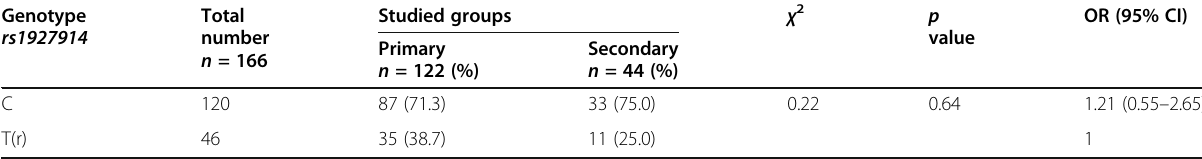
Table 5 Association between TLR genetic polymorphism rs1927914 alleles and epilepsy type Genotype